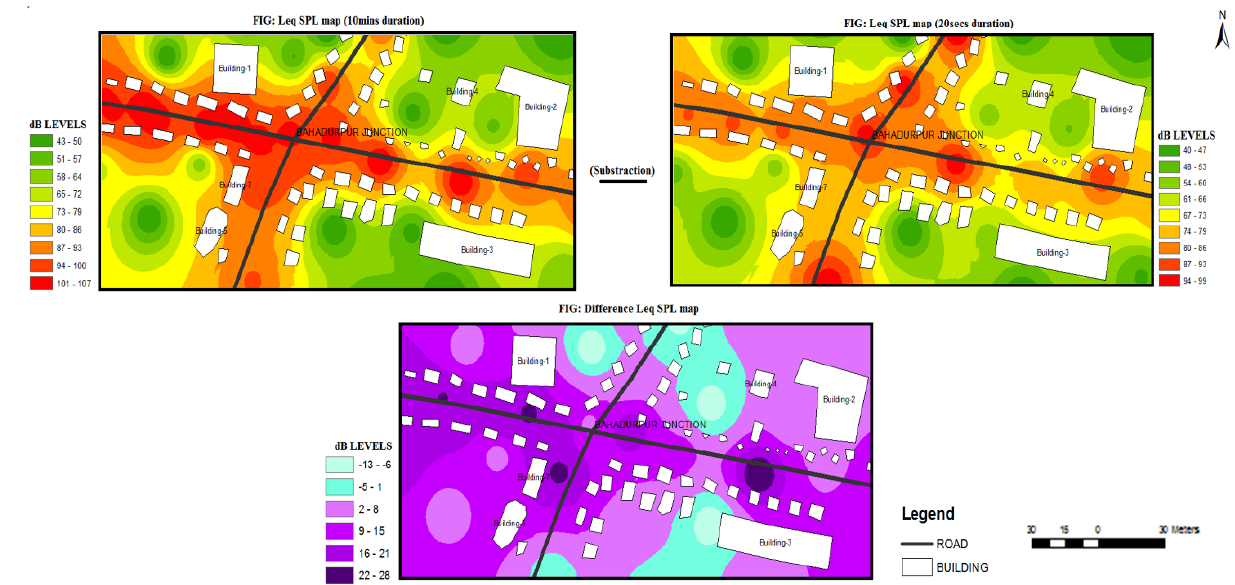
Figure 17. Long vs short noise sampling duration based noise prediction and their difference at M3 time interval (1:00–3:00 p.m.) for the Bahadurpur study area.